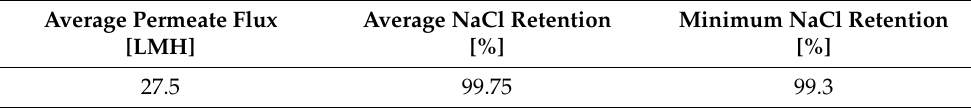
Table 2. Main properties of the ADHR (GE Water&Process Technologies, Feasterville-Trevose, PA, USA) membrane used for RO tests as reported in the manufacturer datasheet. Average salt retention of a spiral wound element after 24 h operation. Individual flow rate of the original element may vary +25%/ − 15%. Testing conditions: 32 g/L NaCl solution; pressure of 55.16 bar; temperature of 25 ◦ C; pH of 7.5; recovery of